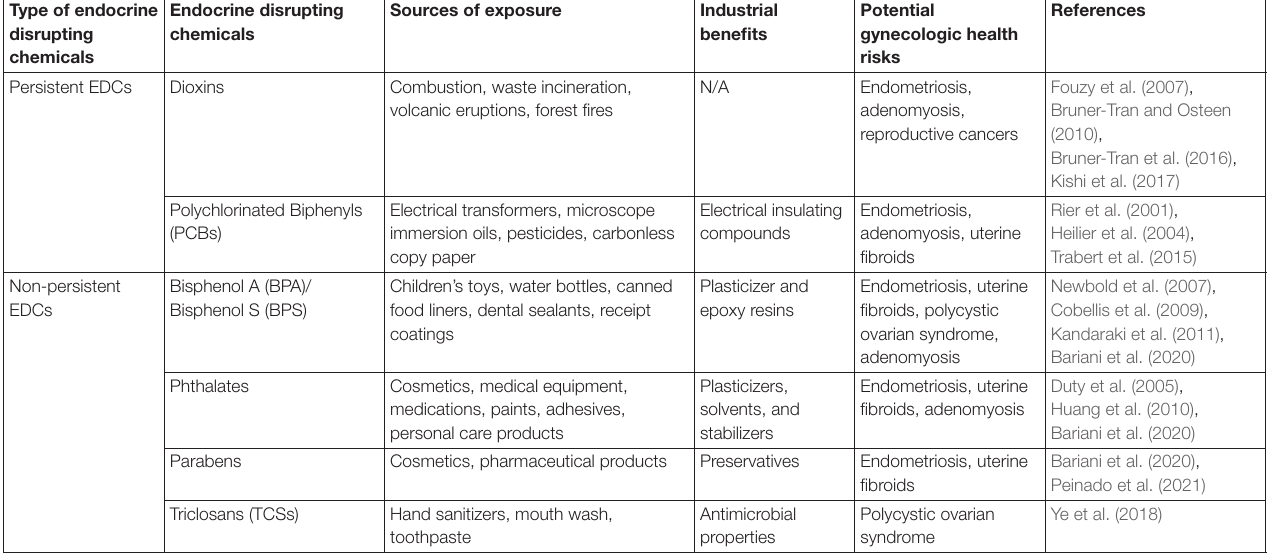
TABLE 1 | Health effects of selected endocrine disrupting